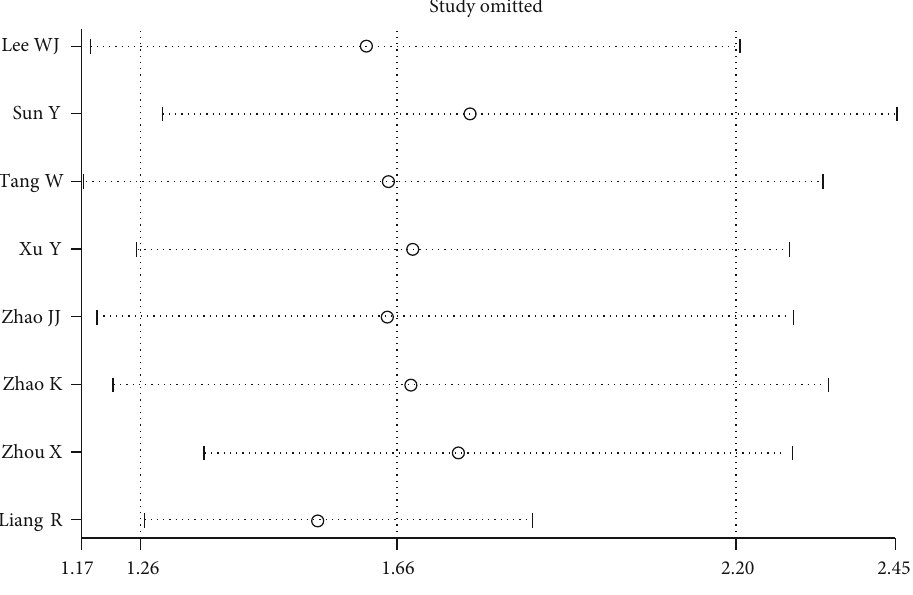
Figure 4: Consequence of sensitivity analysis.